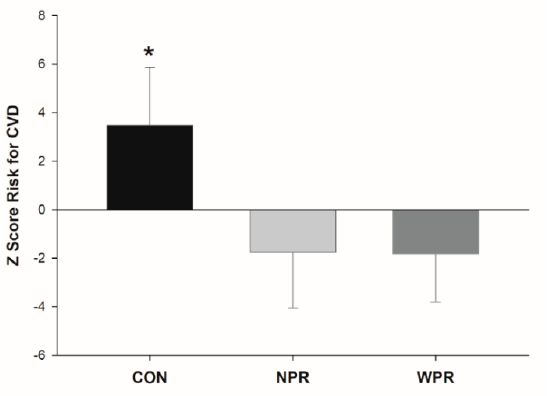
Figure 2. Composite Z-score of the percentage changes from pre- to post-training of the cardiovascular disease (CVD) risk according to groups in older women. CON = control group; NPR = narrow repetition-zone pyramid training; WPR = wide repetition-zone pyramid training; * p < 0.05 vs. NPR and